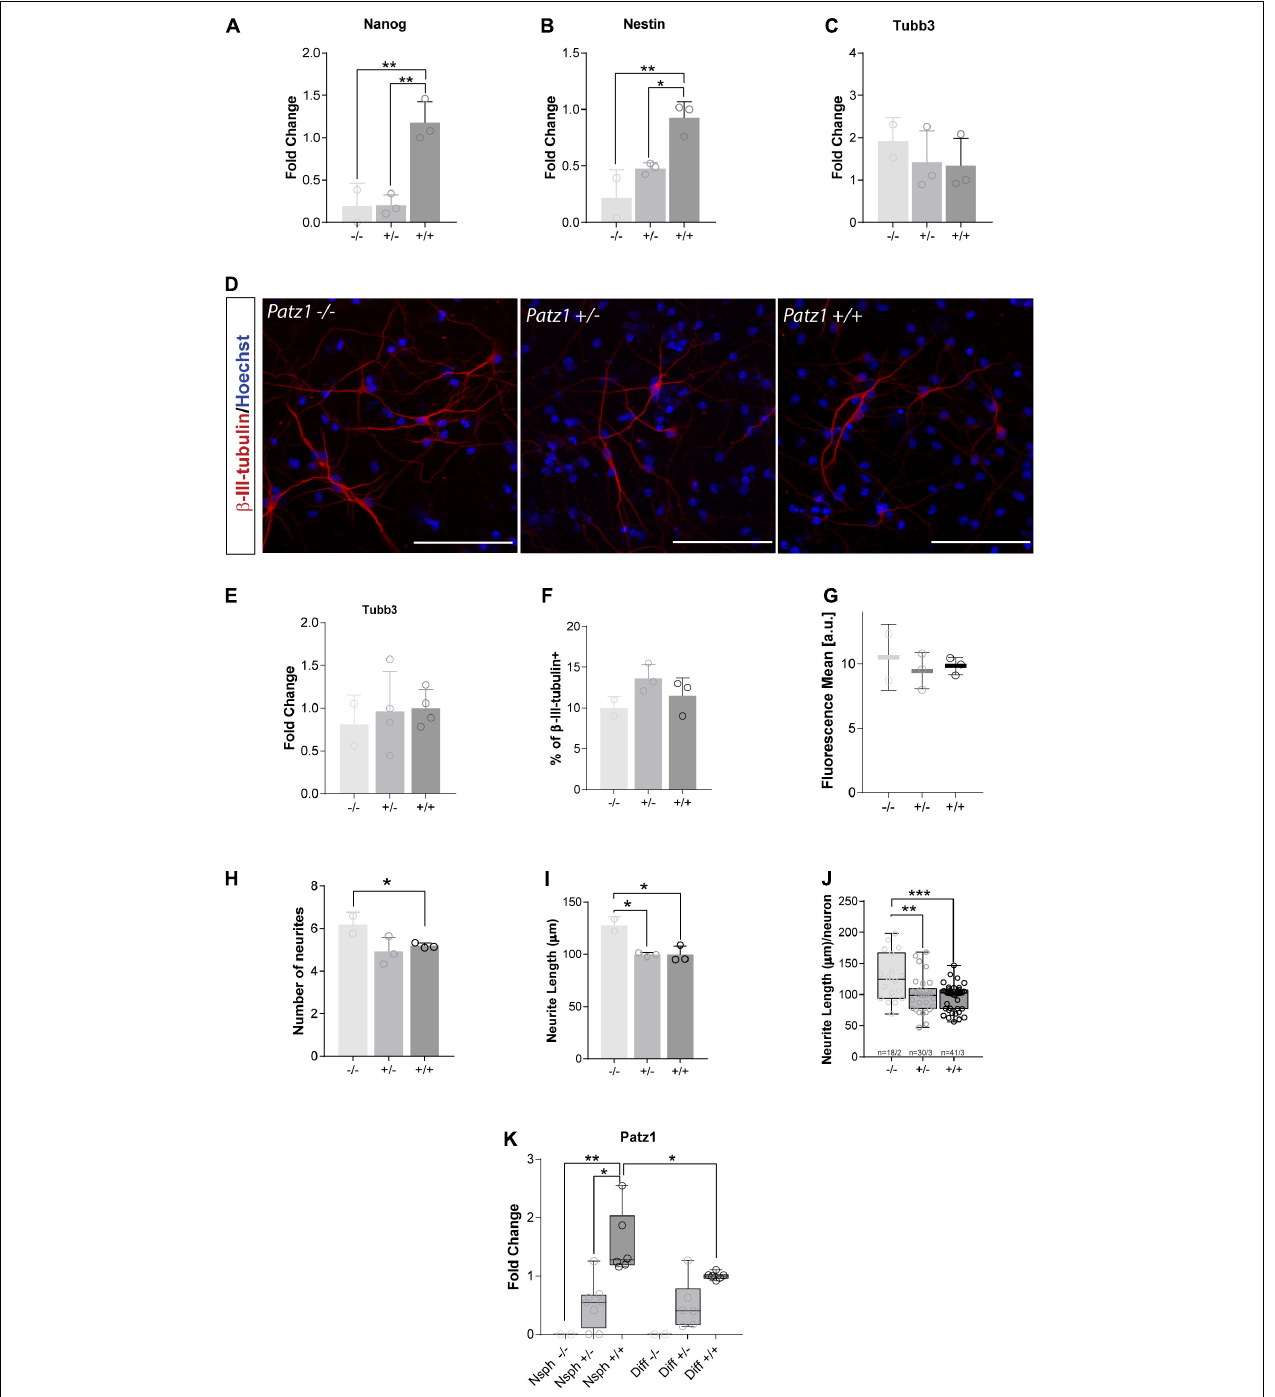
FIGURE 6 | Real time analysis of gene expression and neuronal differentiation in proliferating neurospheres and differentiated cells. (A–C) Relative expression of the genes indicated at the top of each graph is expressed as fold changes with respect to the level of a wild type control, randomly chosen and different for each independent experiment. Mean values ± SD of at least three independent experiments performed in duplicate on samples derived by 2 Patz1 − / − , 3 Patz1 + / − and 3 wild type embryo-derived neurospheres are reported. (D) Representative images of differentiated cells immunolabelled with β -III-tubulin neuronal marker. (E) Relative expression of Tubb3 in differentiated cells as assessed by RT-qPCR. (F–J) Quantitative analysis of the experiment shown in D plotted to show the percentage of β -III-tubulin + cells (neurons) (F) , the mean fluorescence of β -III-tubulin intensity (G) , the number (H) and length (I) of neurite branches, and the neurite length/neuron ratio (J) . (K) Relative expression level of Patz1 in proliferating neurospheres (Nsph) and after 6 days in differentiation medium (Diff). * p < 0.05; ** p < 0.01; *** p < 0.001 vs. wild type control, if not diversely indicated by connecting line, as assessed by ANOVA followed by Tukey’s multiple comparisons test.